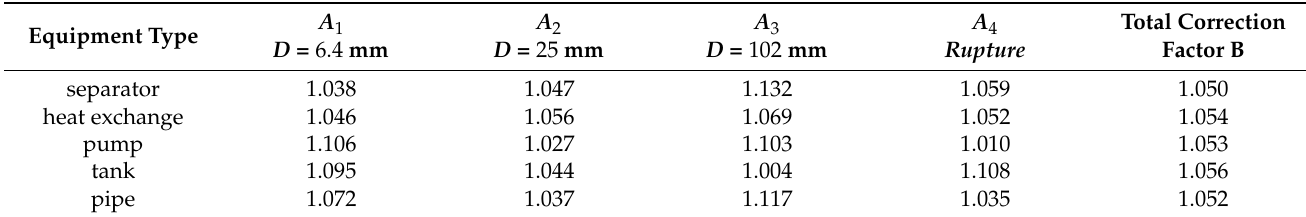
Table 16. Correction factor of calculation formula in equipment damage